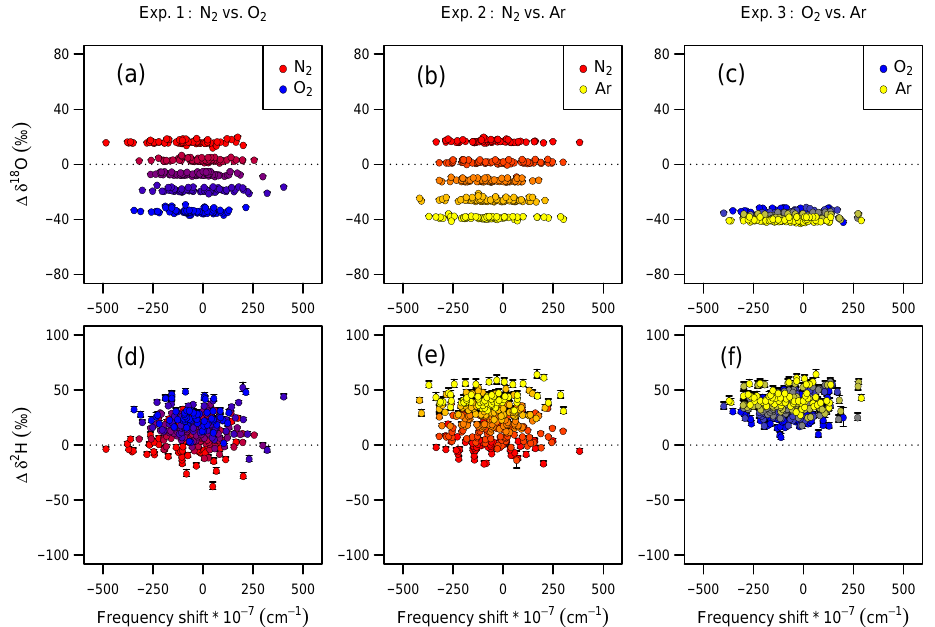
Figure 6. Relationship between the frequency shift, (cid:49)δ 18 O, and (cid:49)δ 2 H values. For each panel, n = 330 measurements of four liquid standards across a range of injection volumes (i.e., 400–2400nL, in 11 steps of 200nL each). Points represent mean values ± SD for replicates of each standard at each injection